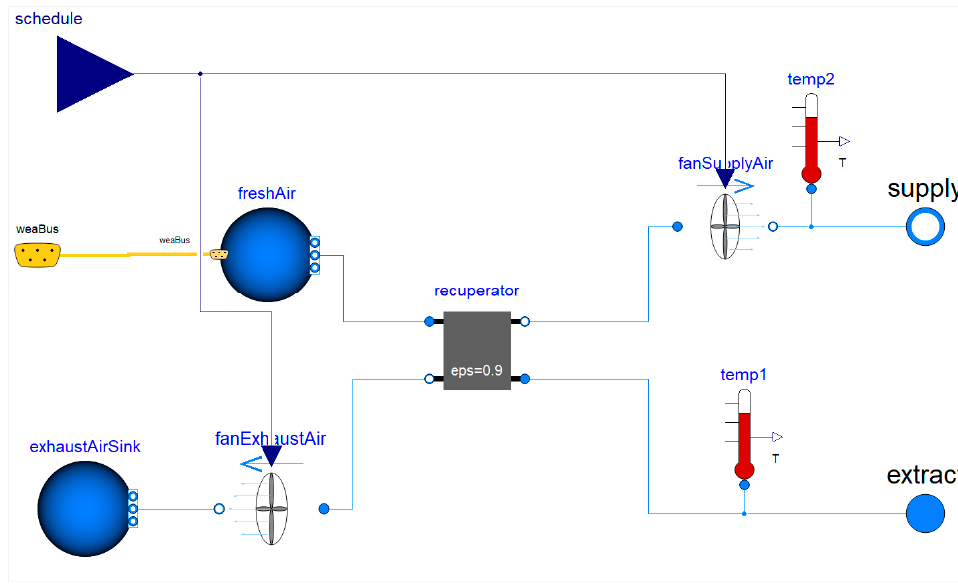
Figure 3. Graphical representation of the mechanical ventilation unit developed within the Dymola environment.